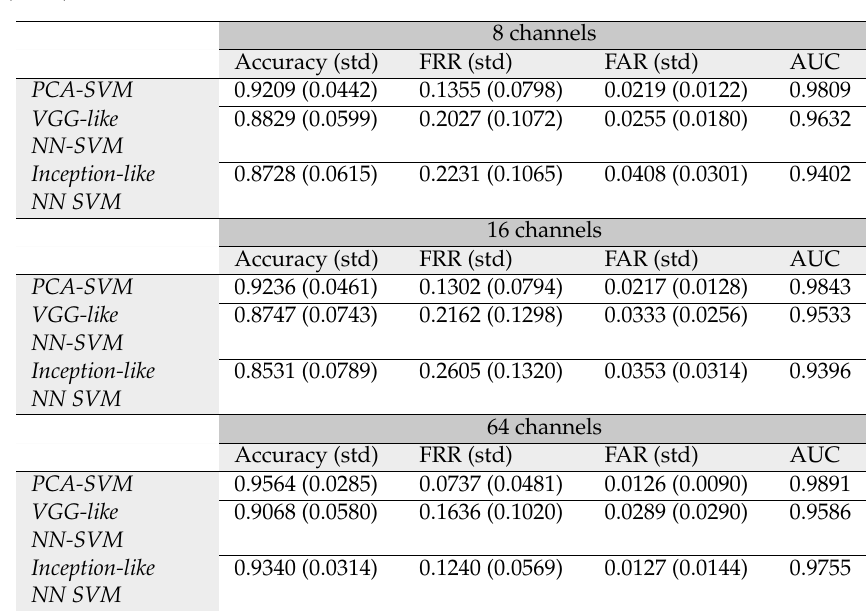
Table 1. Accuracies, FRR and FAR for 8-channel models, 16-channel models, 64-channel models using the optimal threshold. The standard deviation (std) can be found between brackets and the area under curve (AUC) the area under the ROC